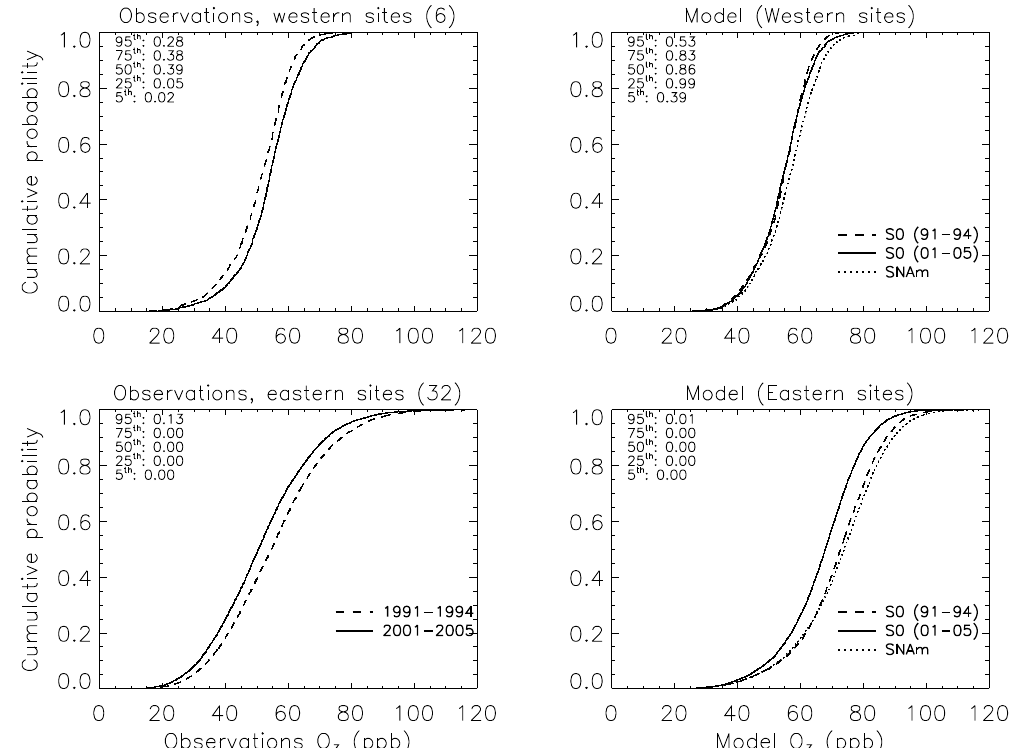
Fig. 06. Cumulative probability distribution of the 8-hour daily maximum summertime (JJA) O 3 concentrations at rural sites in the U.S. in 1991-1994 (dashed line) and 2001-2005 (solid line). For consistency with Europe, we exclude the year 2003. Bottom panels: western U.S. sites. Top panels: eastern U.S. sites (see text for details). Observations and model results are shown in the left and right panels, respectively. The statistical significance level between the two distributions (1991-1994 vs. 2001-2005) is indicated for 5 percentiles in the upper left corner of each panel. The sensitivity simulations ”SNAm” (dotted line) is significantly different from ”S0” (period 2001-2005, see also SOM).